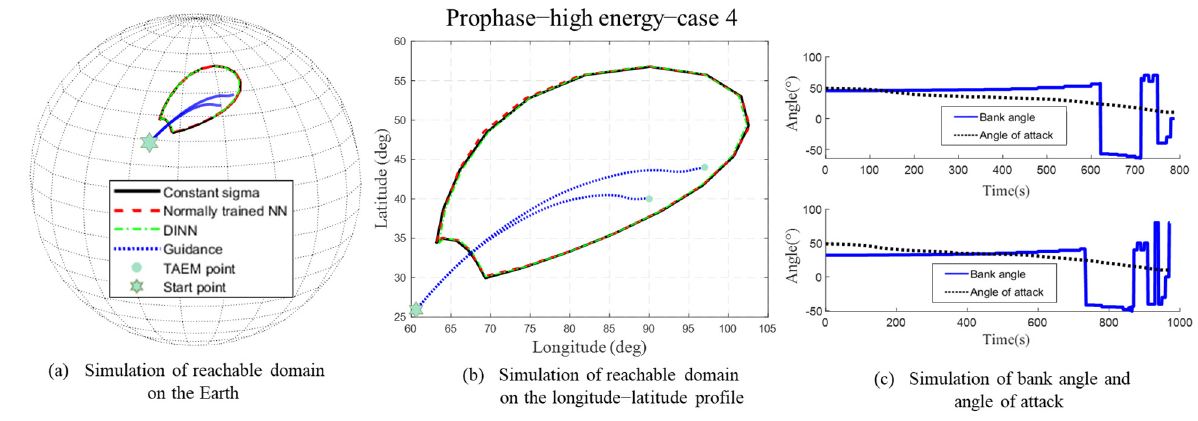
Figure 9. Simulation of high energy Case 4. Table 6. Comparison of each method.